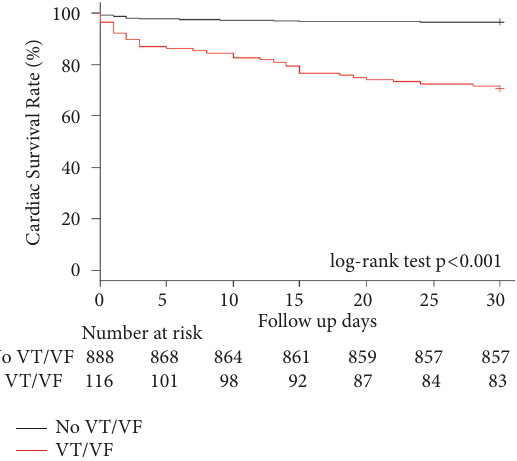
Figure 3: Clinical outcomes regarding cardiac survival rate among patients without VT/VF, those with early VT/VF, and those with late VT/VF during the 30-day period. Notes: log-rank test p < 0.001 for comparisons between patients without VT/VF and those with early VT/VF, those without VT/VF, and those with late VT/VF, and between those with early VT/VF and those with late VT/VF. VT/VF: ventricular tachycardia or ventricular fibrillation.